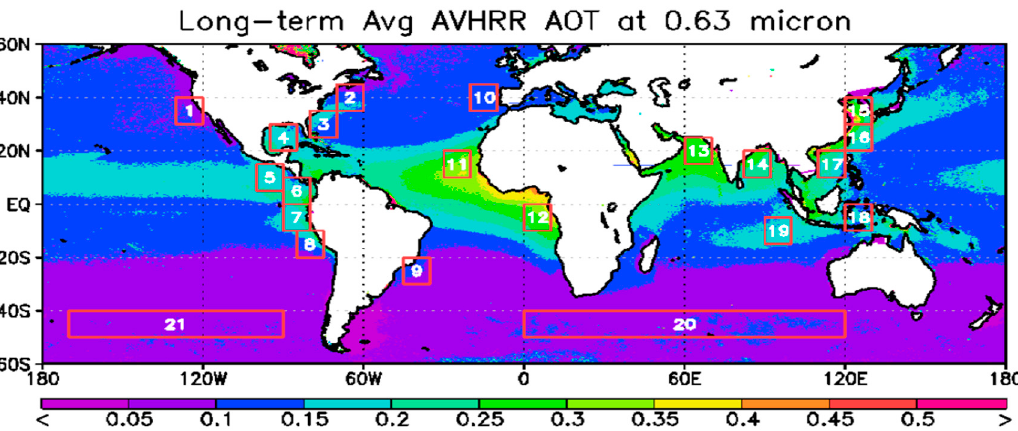
Figure 1. Global map for long-term (1981–2011) averaged monthly mean aerosol optical thickness (AOT). The 21 red boxes (see Table 1 also) are locations selected for regional survey study later. Table 1. Latitude/longitude bounds of twenty-one regions selected for a regional survey study and marked by the red box in Figure 1.